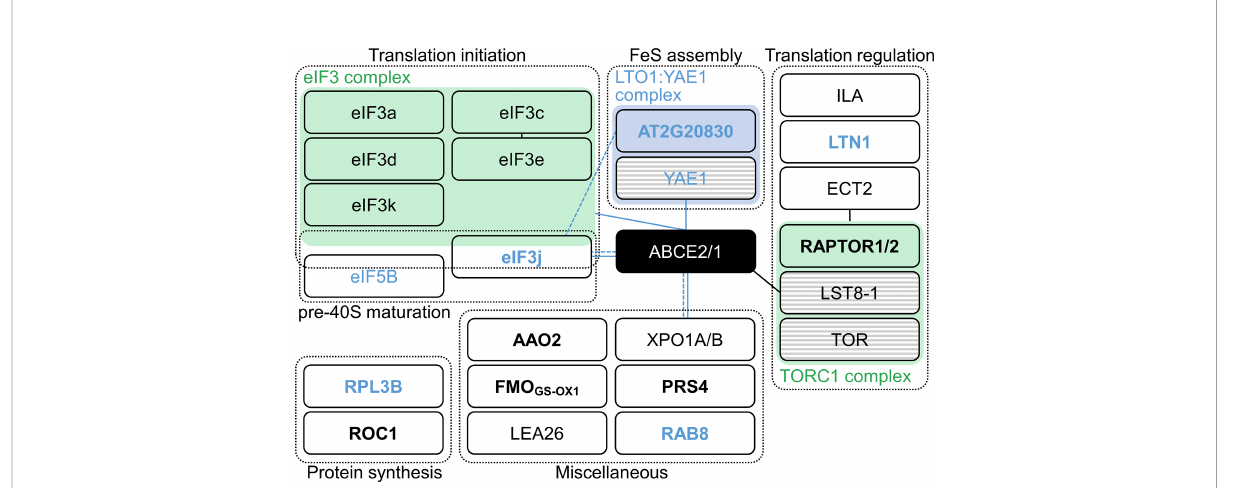
FIGURE 5 Proteins identi fi ed in an ABCE2:YFP co-immunoprecipitation assay. Proteins were grouped within dashed boxes according to their annotated functions for Arabidopsis (names in black letters) or orthologous (names in blue letters) proteins. Green and blue boxes represent complexes that have been described in Arabidopsis and other species, respectively. Proteins in striped boxes were not identi fi ed in our assay but have been included in this Figure because they are known to belong to a given complex. Continuous and dashed lines connecting boxes indicate physical and genetic interactions described elsewhere for Arabidopsis (black) or other species (blue), respectively. For references, see Supplementary Table S8. Names in bold and plain letters indicate proteins unique to or enriched in ABCE2:YFP samples,